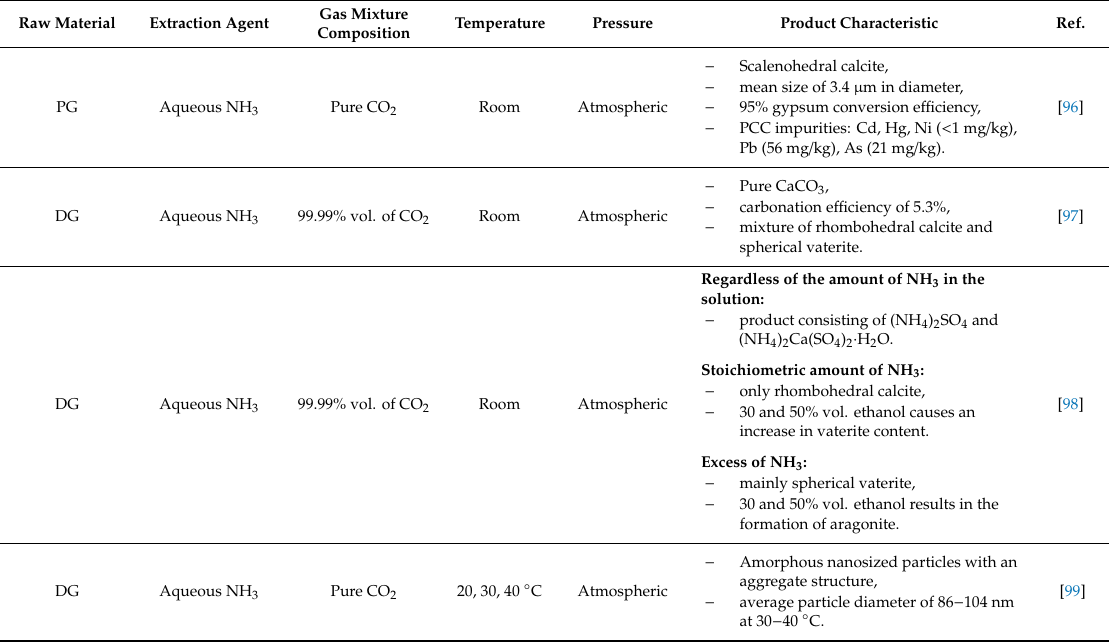
Table 5. Process parameters of CaCO 3 precipitation technologies for waste gypsum utilization using carbonation